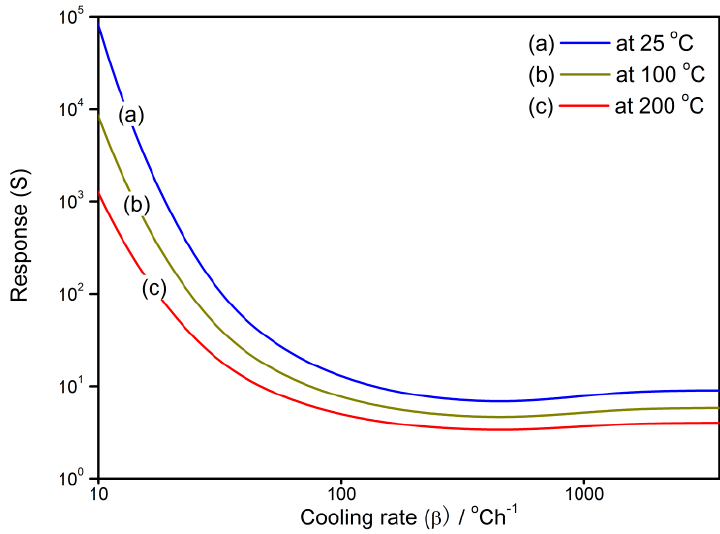
Figure 9. The relationship between the sensor response to reducing gas and the cooling rate at the operating temperatures of 25, 100, and 200 °C.